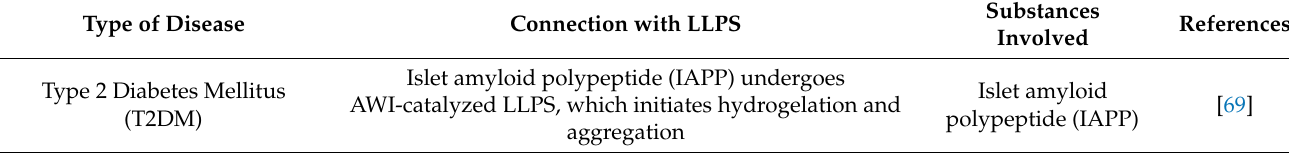
Table 2. Roles of LLPS in metabolic